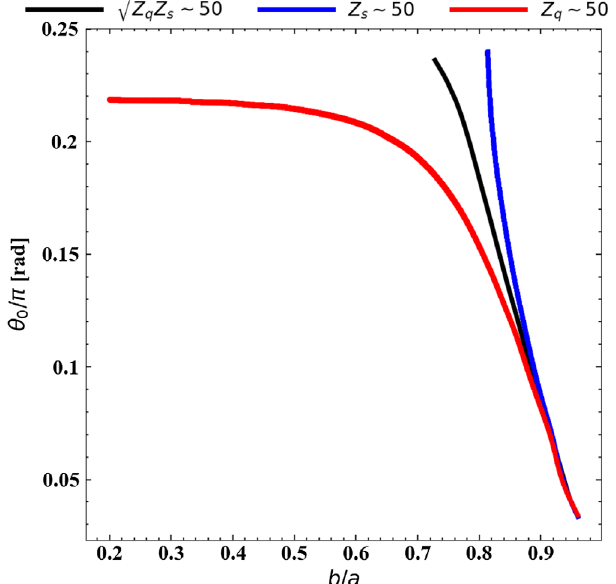
14. θ 0 as a function of b=a when the characteristic impedances in the quadrupole mode (red), sum mode (green) and their geometric mean (black) are each set to constant value of 50 Ω